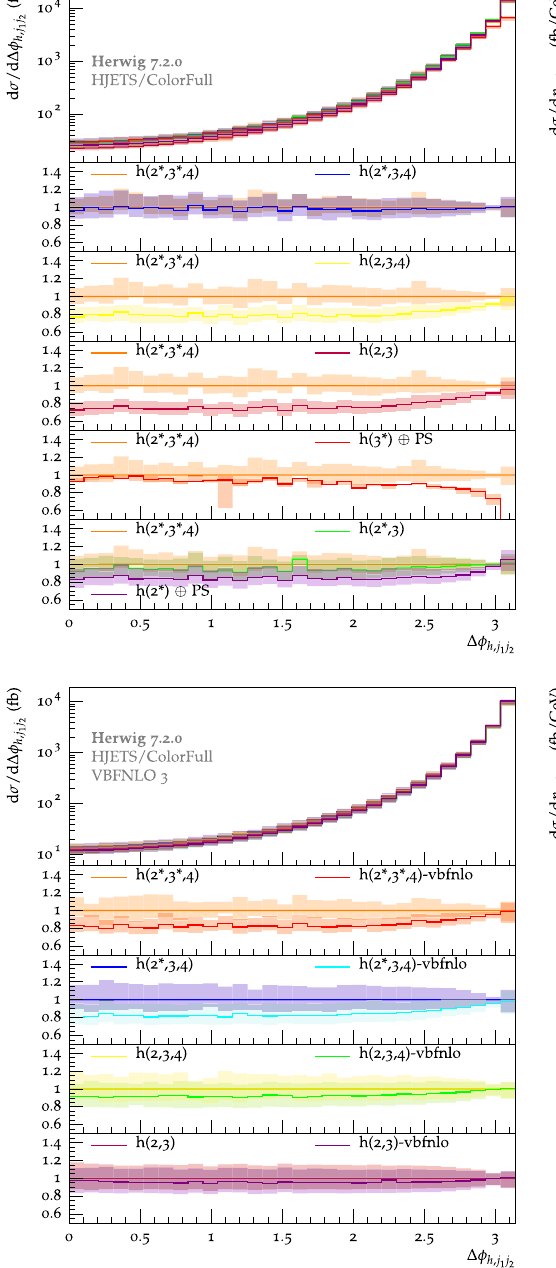
(cid:2) (cid:2) h ( 3 (cid:3) ) Fig. 8 Shown are distributions in the azimuthal angle difference PS, and h ( 2 (cid:3) ) PS are compared to the h ( 2 (cid:3) , 3 (cid:3) , 4 ) predic- between the Higgs boson and system formed by the leading two jets tion (INCL selection cuts). In the bottom row we compare the merged Δφ setups using VBFNLO MEs against the setups using HJets MEs for h , j 1 j 2 (left column) and in the transverse momentum of the Higgs LOOSE selection cuts. Shown in the figures are theory error bands due boson plus two leading jets system p T , hj (right column). In the top 1 j 2 to the variation of the factorization and renormalization scales row predictions h ( 2 (cid:3) , 3 (cid:3) , 4 ) , h ( 2 (cid:3) , 3 , 4 ) , h ( 2 , 3 , 4 ) , h ( 2 (cid:3) , 3 ) , h ( 2 , 3 ) , matching by merging setups h ( 2 , 3 ) and h ( 2 (cid:3) , 3 ) follow a going from the LO MEs to NLO MEs the two predictions (cid:2) PS setup. When comparing similar pattern to the h ( 2 (cid:3) ) separate even further. This suggests that applying an over- merged setups using the HJets MEs against the VBFNLO all K factor to predictions using LO merged setup may not MEs for the LOOSE selection cuts we see deviations in the describe the physics very distribution. For Δφ h , j we notice when tail of the p T , hj 1 j 2 1 j 2